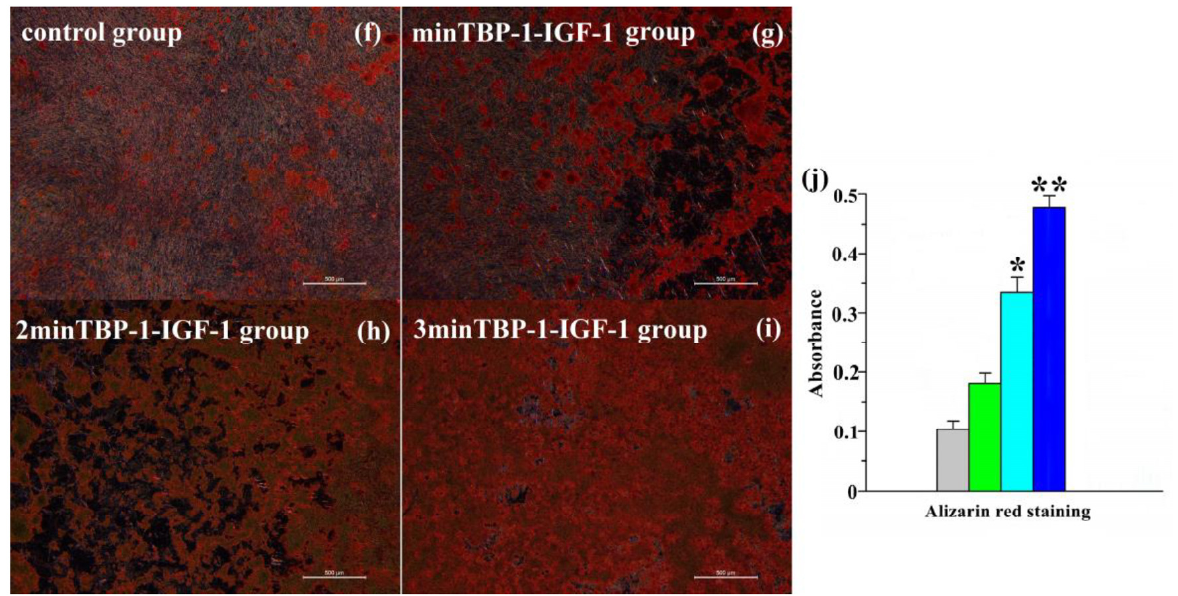
Figure 4. ( a – d ) ALP activity was assessed by staining with BCIP/NBT 7d after induction; ( e ) absorbance (405 nm) after ALP staining; ( f – i ) images of mineralized clots were obtained by alizarin red S staining 14 d after osteogenesis induction; ( j ) absorbance (570 nm) after alizarin red S staining. n = 10, * p < 0.05, ** p < 0.01.